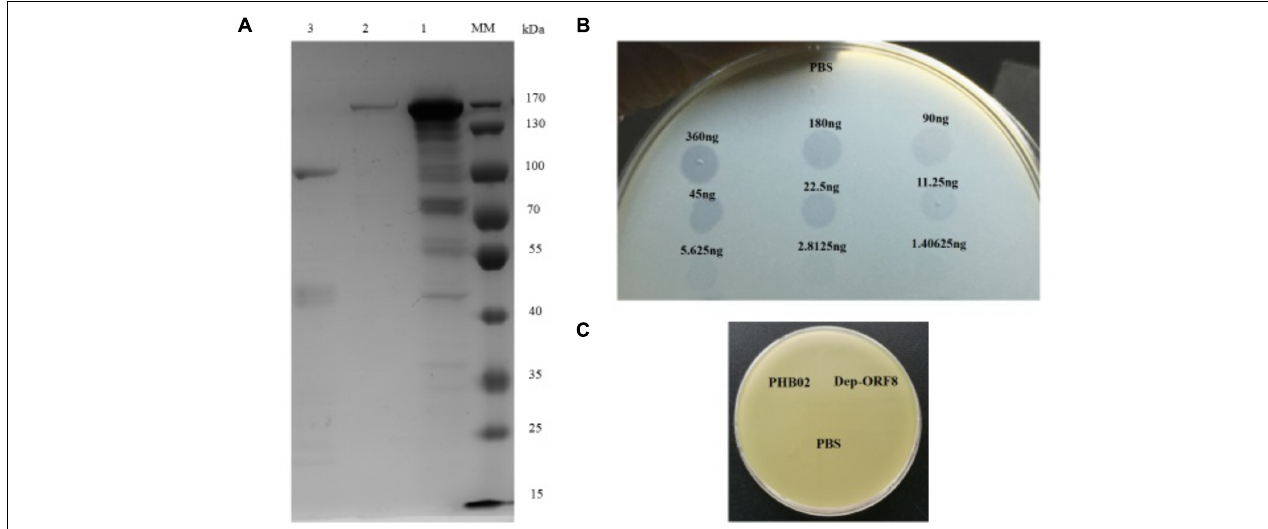
FIGURE 1 | Dep-ORF8 overexpression and activity. (A) Sodium dodecyl sulfate polyacrylamide gel electrophoresis analysis of purified Dep-ORF8. Lane MM, protein marker; lane 1, 20 µ g of supernatant from the induced E. coli BL21(DE3) cells; lane 2, 200 ng of purified Dep-ORF8 (containing the his-tag); lane 3, 200 ng of purified Dep-ORF8 (minus the his-tag). (B) Activity of depolymerase Dep-ORF8 against wild-type P. multocida strain HB03. Serial dilutions of Dep-ORF8 were spotted onto the plate containing P. multocida HB03. Elution buffer diluted in PBS was used as a control. (C) Spot tests examining the ability of phage PHB02 and depolymerase Dep-ORF8 to lyse the capsule-deficient mutant strain. Aliquots (5 µ l) of phage PHB02 at a concentration of 10 8 pfu/ml and depolymerase Dep-ORF8 (360 ng) were spotted onto a plate containing the mutant strains. The plates were observed for 6 h at 37 ◦ C.